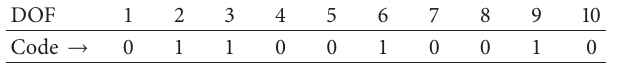
Table 1: An example of a firefly code.